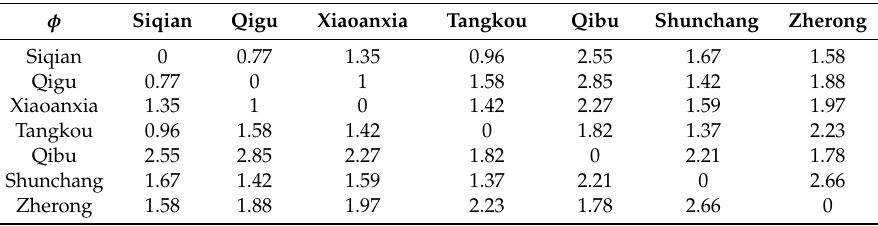
Table 4. Results of catchment/region similarity.